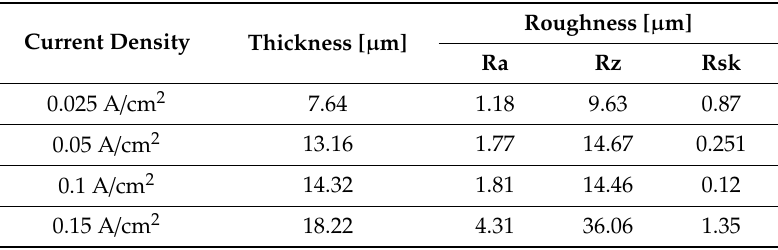
Figure 3. Morphology of the PEO coating prepared in the electrolyte with 8 g / L of Na 3 PO 4 · 12H 2 O and current density of 0.025 A / cm 2 ( a ), 0.05 A / cm 2 ( b ), 0.1 A / cm 2 ( c ) and 0.15 A / cm 2 ( d ). Table 3. Thickness and roughness parameters of the PEO coatings prepared in the electrolyte with 8 g / L of Na 3 PO 4 · 12H 2 O.